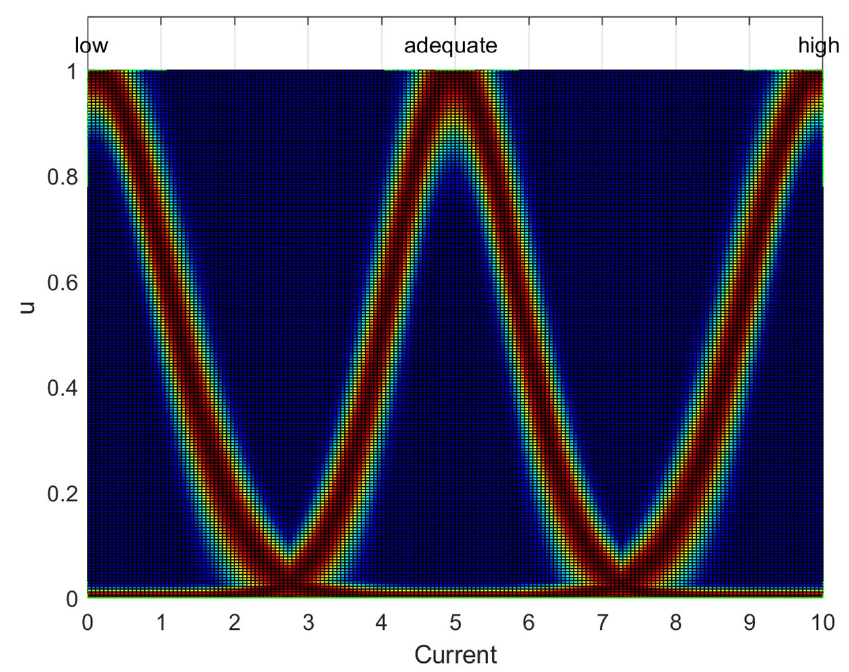
Figure 6. Nonmembership functions of the current input variable.